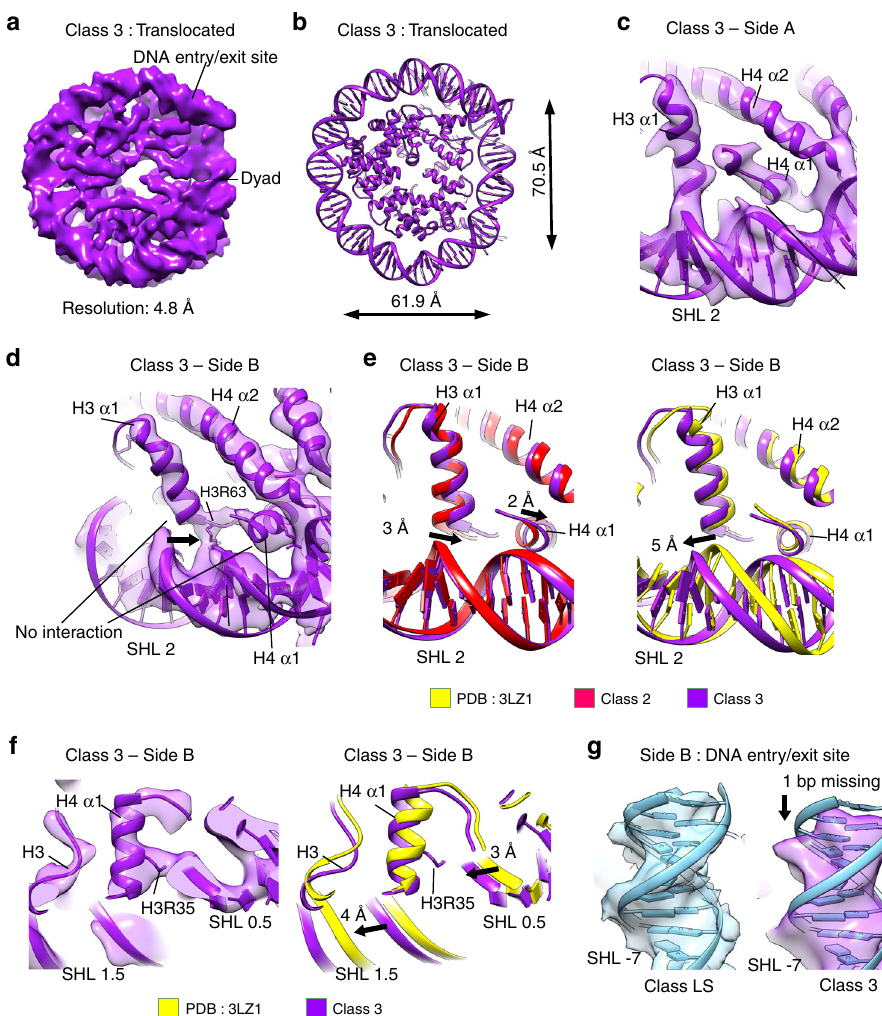
Fig. 4 Conformational changes in the histone octamer translocate DNA. a Cryo-EM map of the NCP Class 3 (translocated nucleosome) at 4.8 Å (0.143 FSC cutoff). Class 3 contains 39 000 particles. b Global changes in the Class 3 structure. The histone octamer in the Class 3 NCP is 62 Å wide along the symmetry axis (distance between nucleotides 2 and 38) and 70 Å in the perpendicular direction (distance between nucleotides 17 and 58). c , d Fitting of the Class 3 (purple) model into the Class 3 map. On the side A, the H3 α 1 interacts with the left DNA strand of the superhelix SHL 1.5 c . On the side B, the H3 α 1 interacts with the right DNA strand of SHL 1.5 d . The H4 α 1 is detached from the DNA at SHL 1.5 on both sides. e Comparison of the X-ray structure (yellow), the Class 2 (red), and the Class 3 models (purple). The degree of movement between the Class 2 and the Class 3 models is shown. The H3 α 1 moves back 3 Å in the Class 3 compared with the Class 2. The H3 α 1 reverts to similar position that it occupies in X-ray structures, but now it interacts with another DNA strand. DNA at SHL 1.5 moves 5 Å toward SHL 2 compared with X-ray structures. The H4 α 1 moves back 2 Å in the Class 3 compared with the Class 2. f The H4 α 1 detached from the DNA at SHL 1.5 and interacts with the DNA at SHL 0.5. DNA at SHL 1.5 moved 4 Å toward SHL 2 compared with X-ray structures and detaches from the H4 α 1. DNA at SHL 0.5 moved 3 Å toward SHL 2 compared with X-ray structures and now interacts with the H4 α 1. g The model for Class LS_C1 (Class LS reconstructed with C1 symmetry) was fi tted into Class LS_C1 and Class 3 cryo-EM maps. In the Class 3 map, DNA at one entry/exit site is shorter than in Class LS_C1 map, indicating that ~ 1 bp of DNA moved toward the other